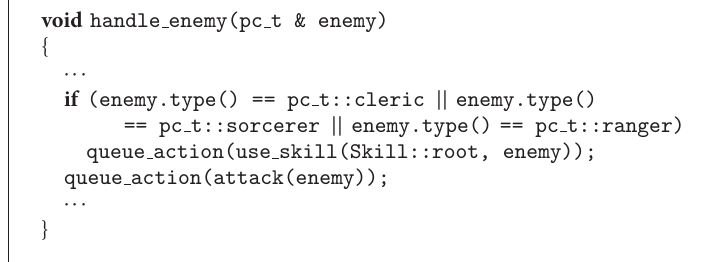
Algorithm 1: Fortress Defender combat code snippet.